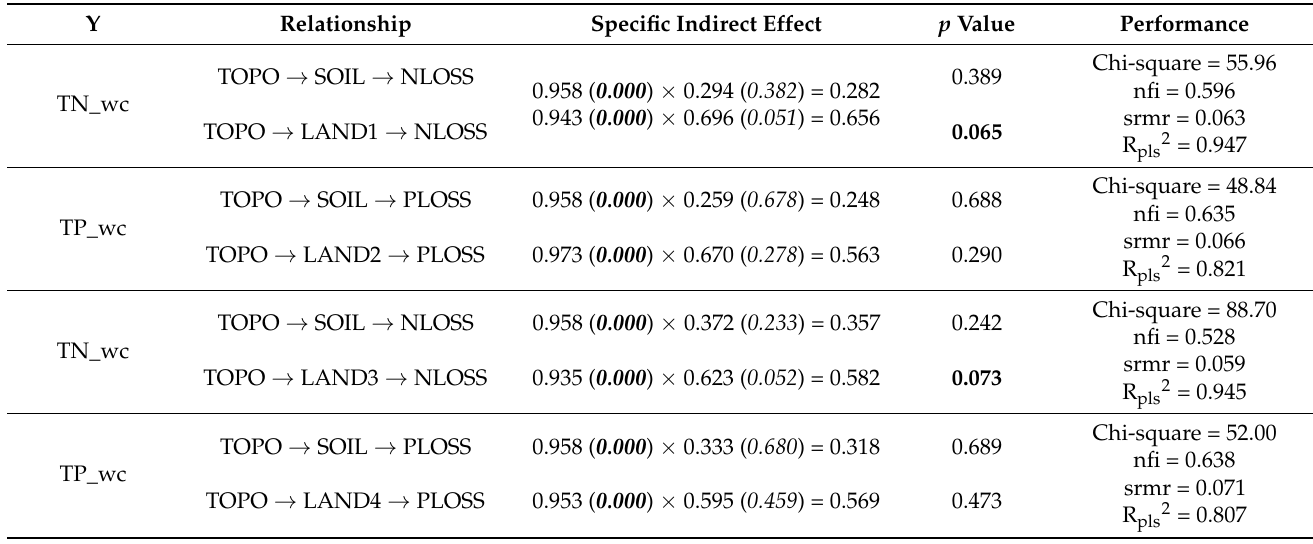
Table 7. Effects and performance of structural equation models for the path analysis of the relation- ships of the N and P loadings with the LAND and SOIL